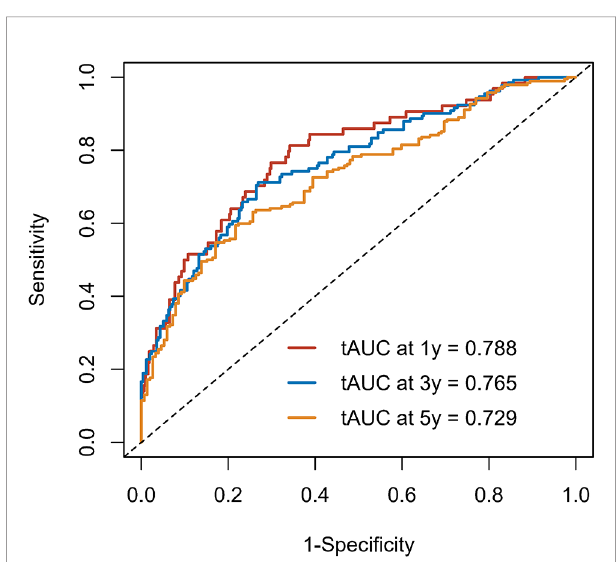
FIGURE 5 | The time-dependent receiver operating characteristic (tdROC) curve of the prognostic nomogram in the training group.